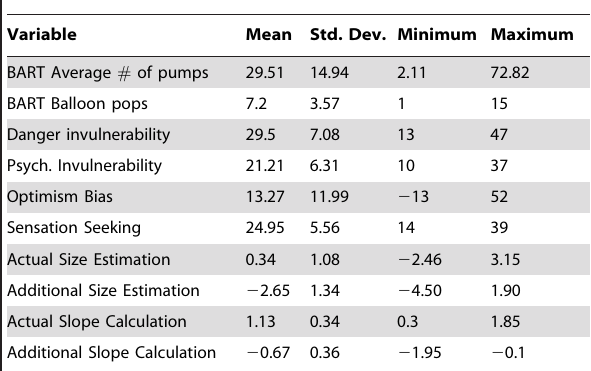
Table 1. Descriptive statistics for key